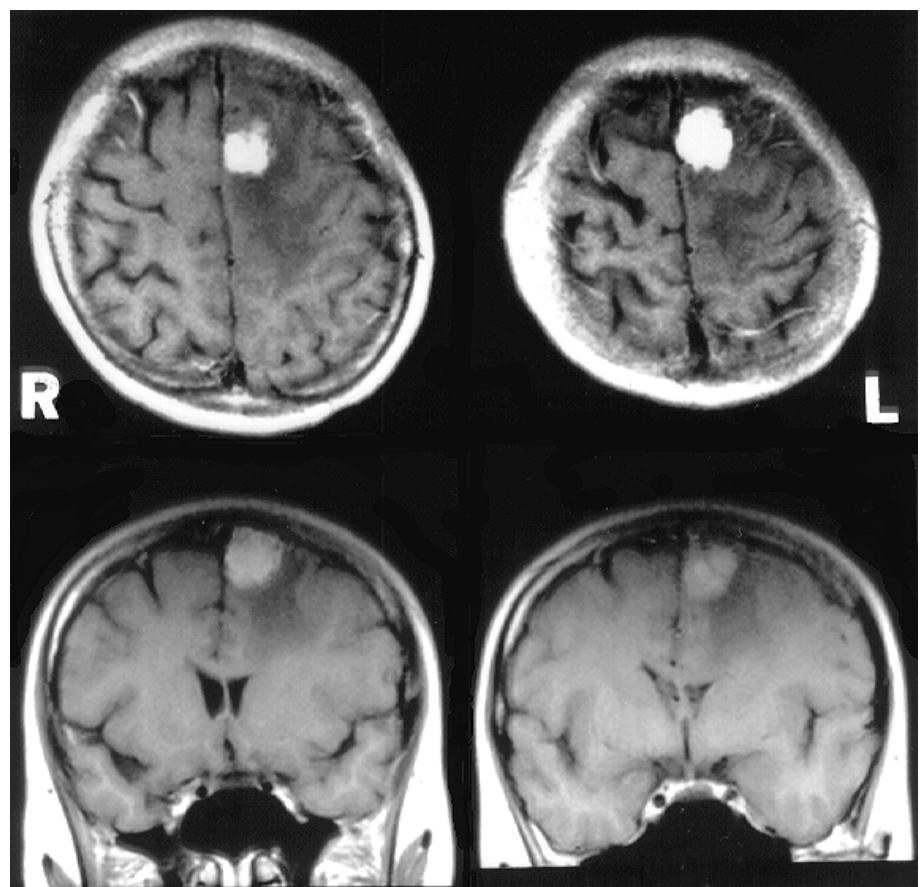
Fig. 1. Gadolinium-enhanced (cid:7) 1 -weighted MRI images revealed an enhanced mass lesion in the left medial frontal lobe with surrounding low intensity